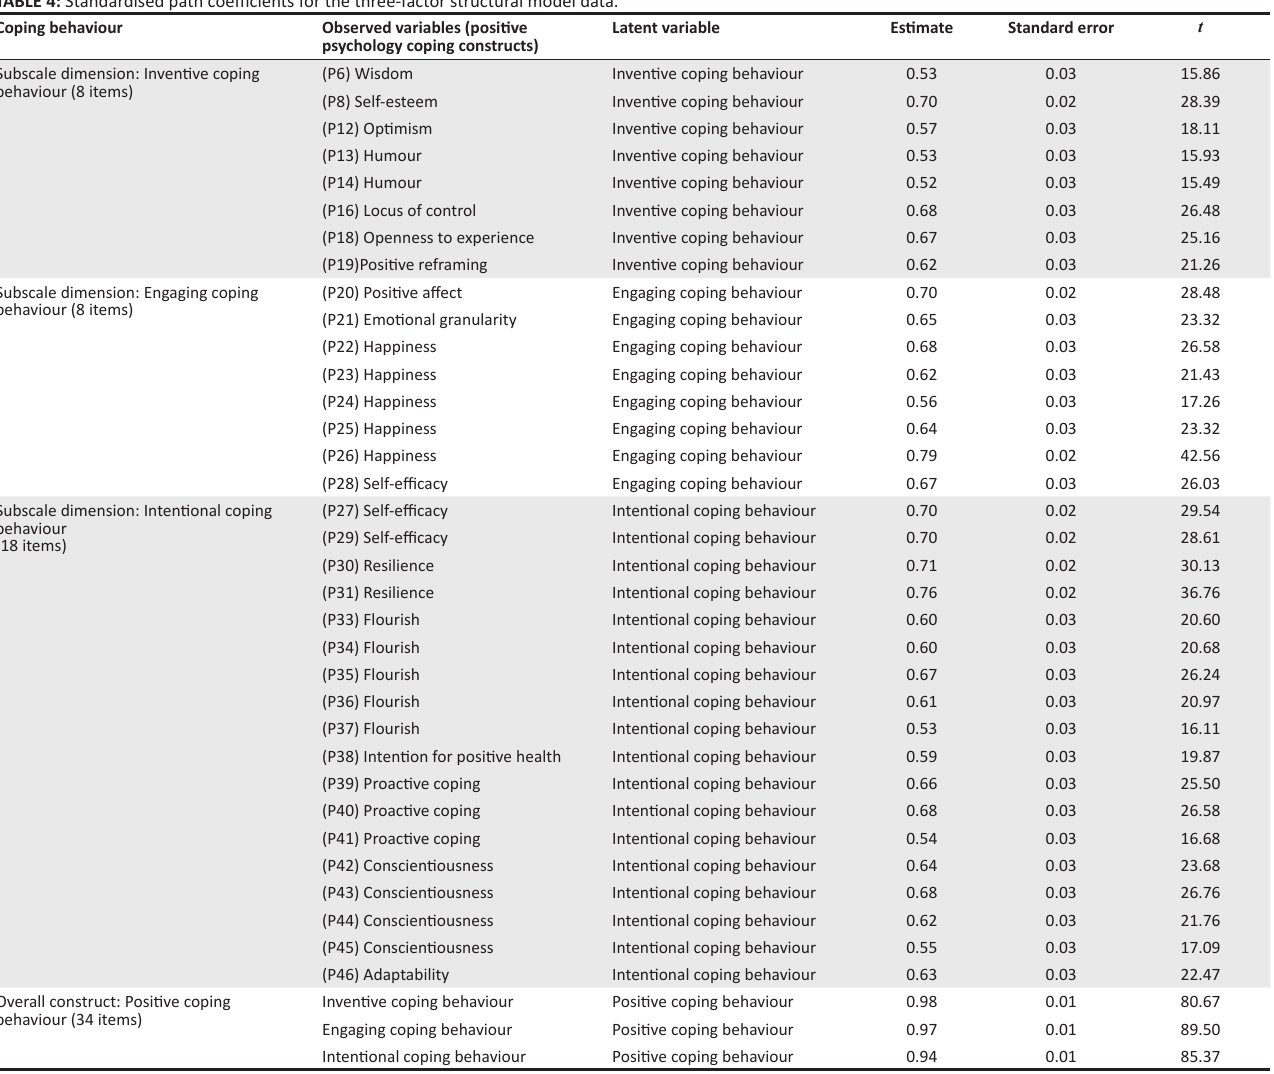
TABLE 4: Standardised path coefficients for the three-factor structural model data. Coping